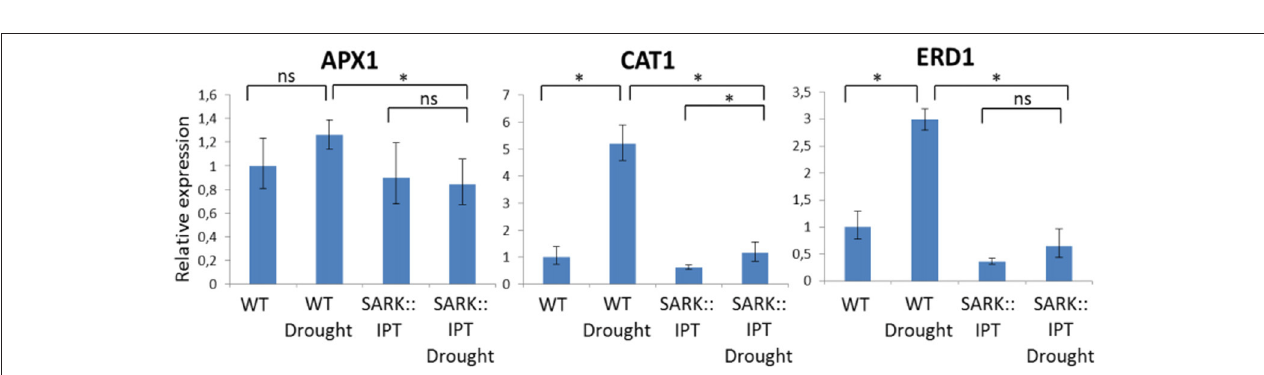
FIGURE 1 | Responses of SARK::IPT transgenic Arabidopsis plants to drought conditions followed by re-watering. Arabidopsis plants were grown for 40 days under long day regimes (16h light, 8h darkness) and were then subjected to drought stress by withholding water for 5 days. (A) w.t. and transgenic plants SARK::IPT after 5 days of drought. (B) w.t. and transgenic plants SARK::IPT after 7 days of re-watering.